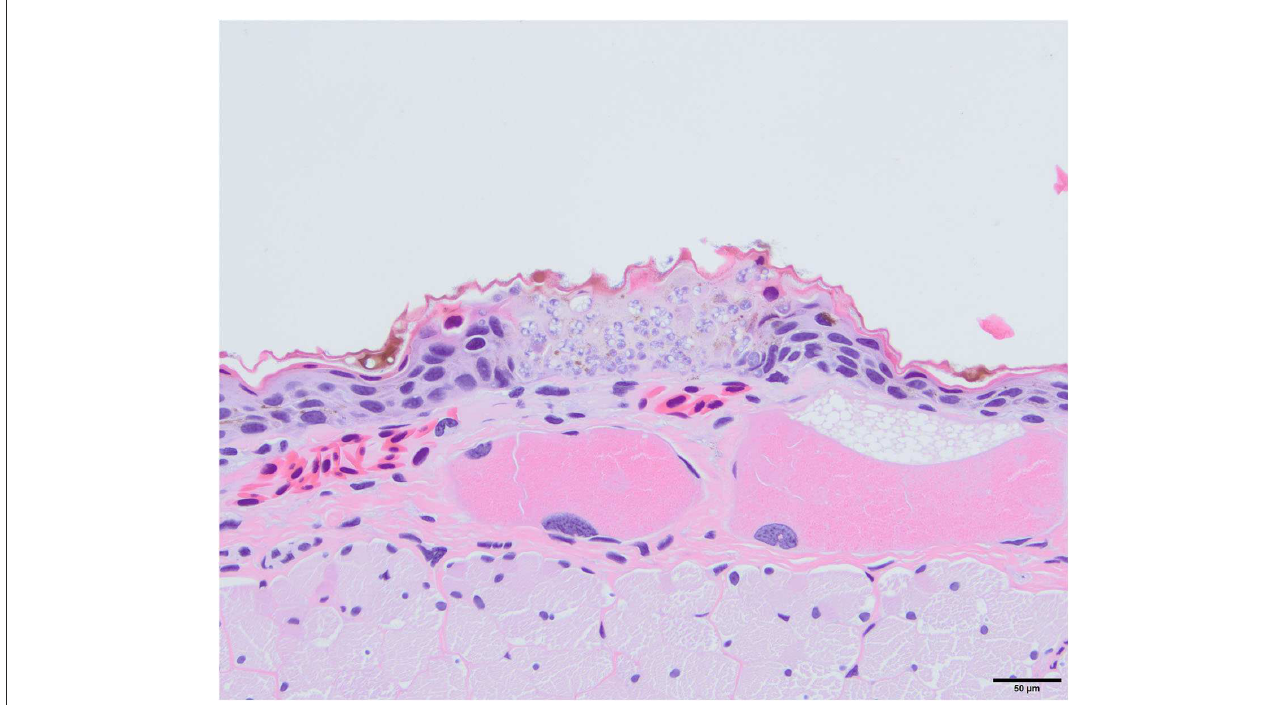
FIGURE15 Photomicrograph stained with hematoxylin and eosin (H&E) of a skin lesion caused by Batrachochytrium salamandrivorans ( Bsal ) chytridiomycosis. There is full thickness invasion of the epidermis by Bsal thalli along with associated epithelial damage which is characteristic of skin lesions caused by this pathogen.